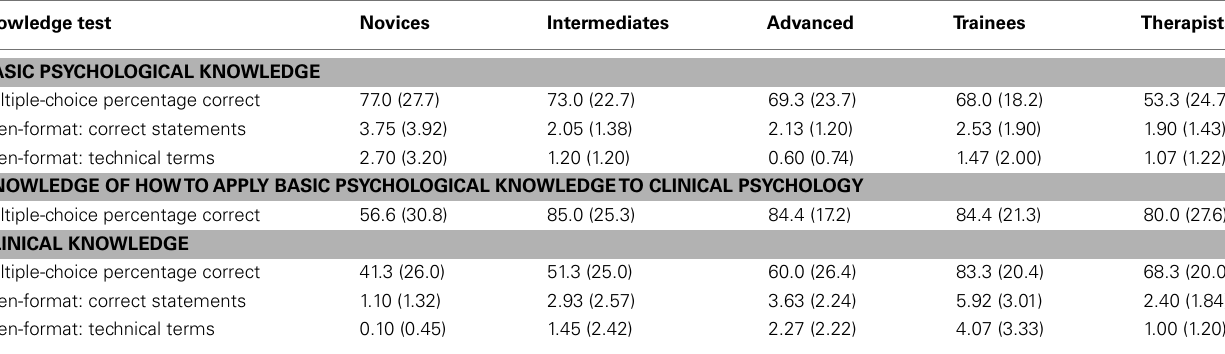
Table 1 | Means and standard deviations (in parentheses) for the knowledge test with multiple-choice items and open-format questions.